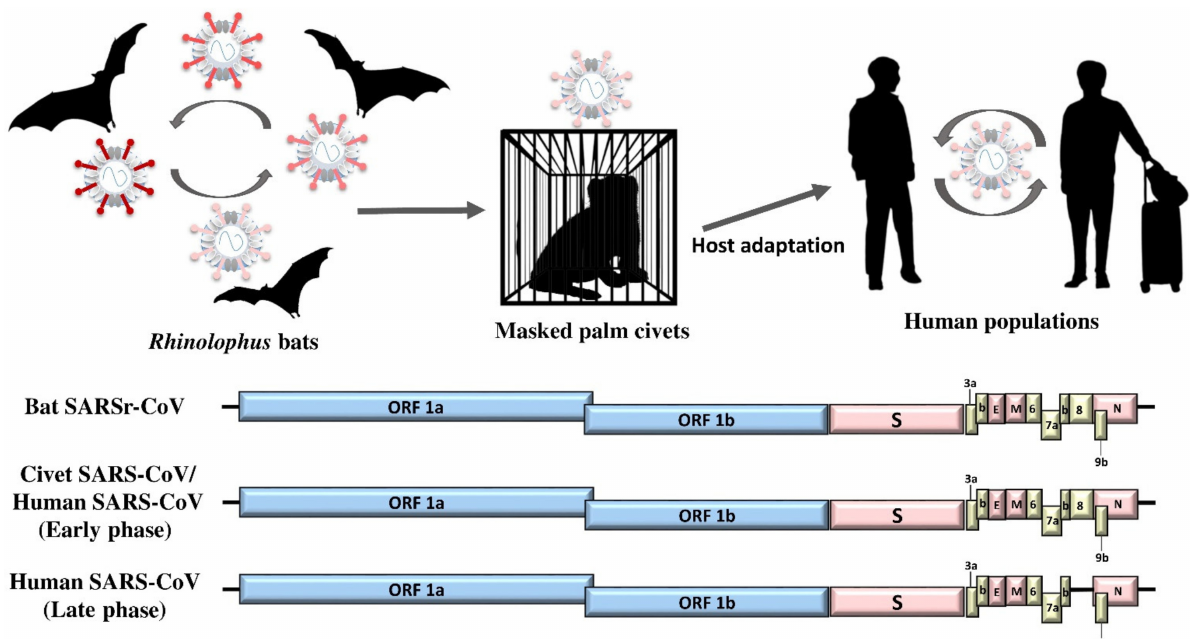
Figure 1. Overview of interspecies transmission events of SARS epidemic in 2003 and genome organizations of SARSr-CoV from different hosts. Arrows indicate the direction of viral interspecies jumping and viral molecular evolution between different host species. Circular arrows indicate the circulation of virus within the population. ORF1a and ORF1b are represented by blue boxes, structural proteins by pink boxes, and accessory proteins by yellow